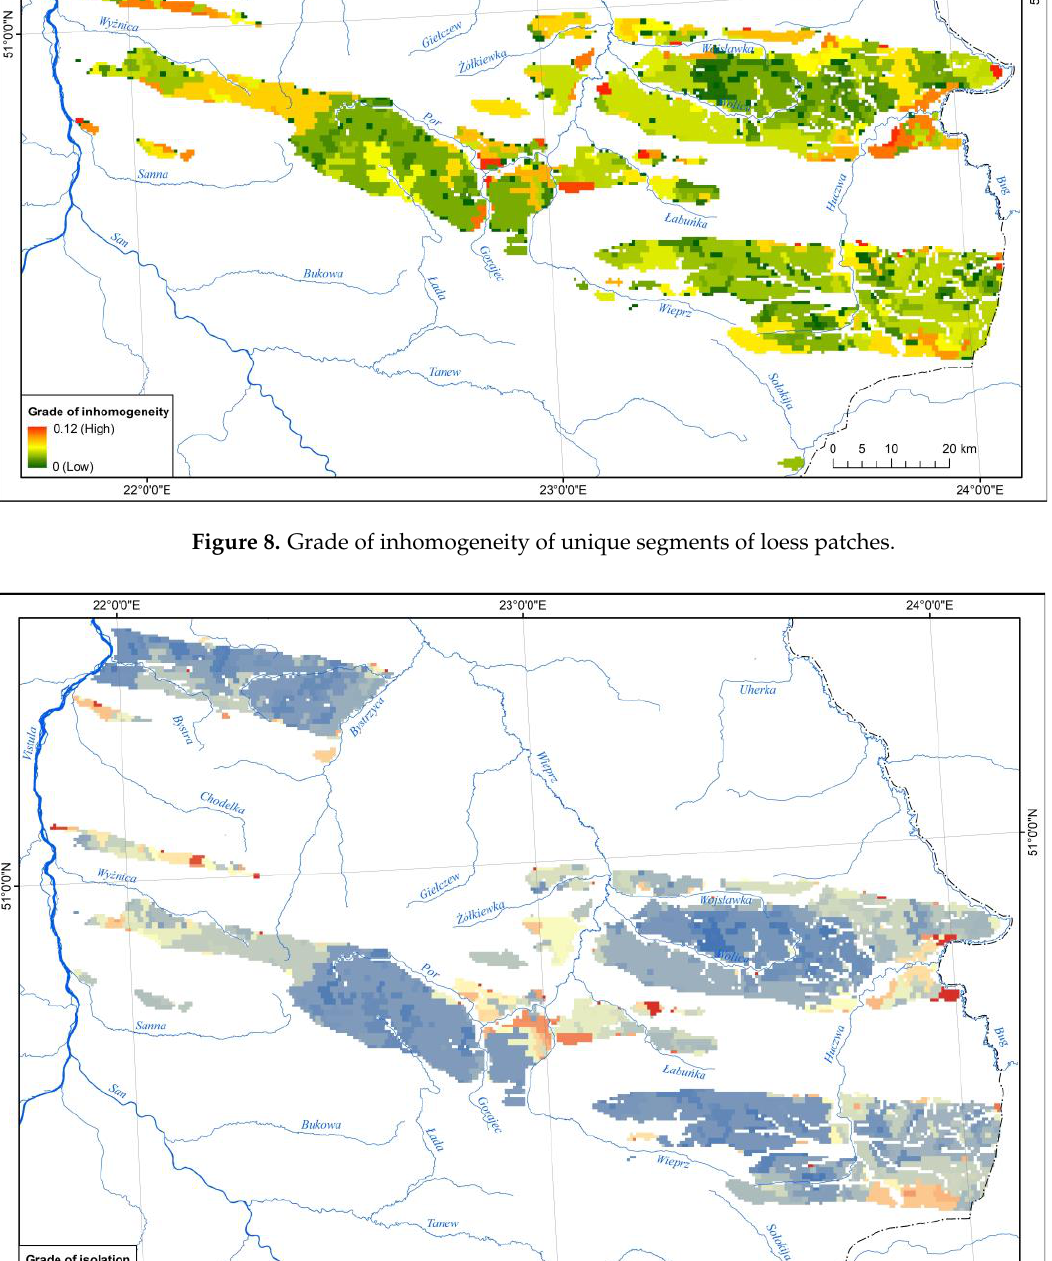
Table 5. Changeability of values of inhomogeneity (IN) and isolation (IS) indices in relief types and subtypes.